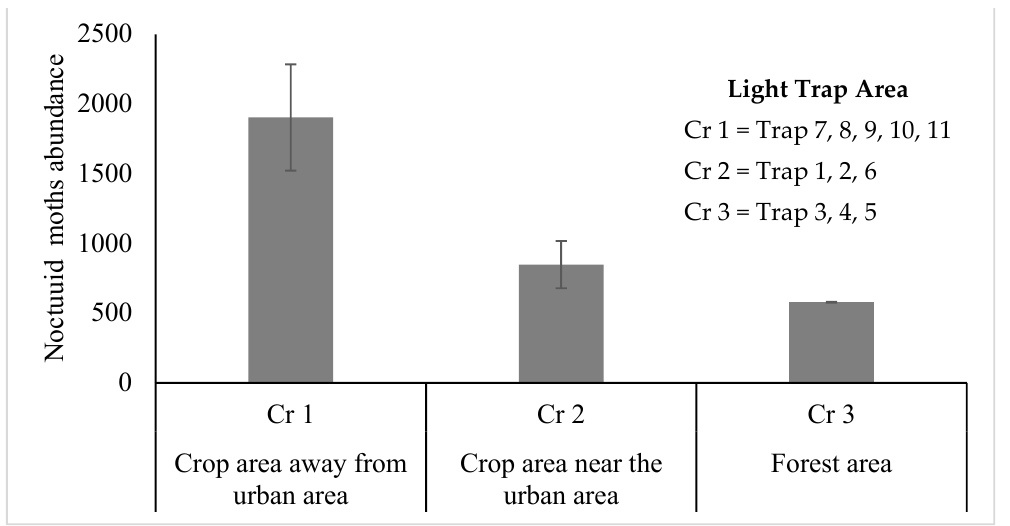
Figure 4. Noctuid moth abundance in different type of habitats in Multan. Different letters indicate significant differences at ( p < 0.05).